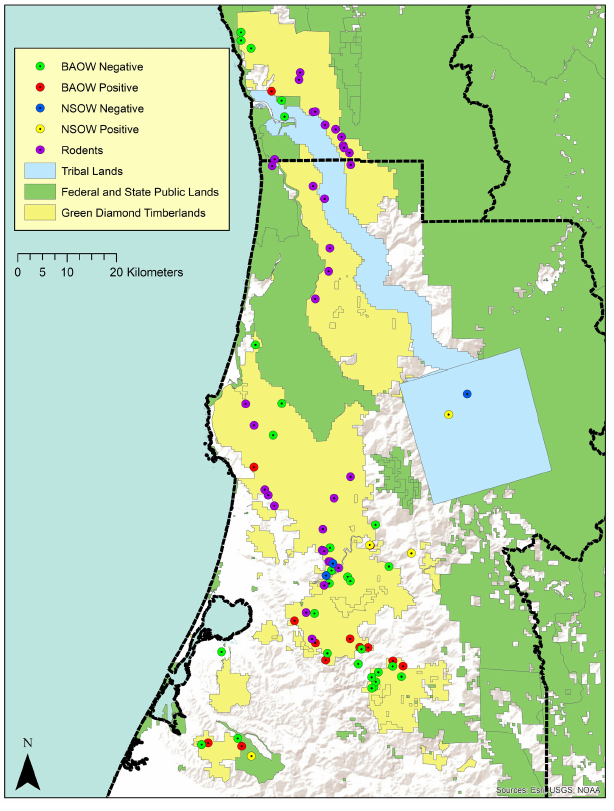
Fig. 2 . Collection locations for Barred Owls (BO; Strix varia ), and rodents and their anticoagulant rodenticide (AR) status on Green Diamond private timberlands in Northwestern California, USA. Positive BO are represented by yellow circles, respectively. The northern study area in Del Norte County and the southern study area in Humboldt County are delineated by dashed county